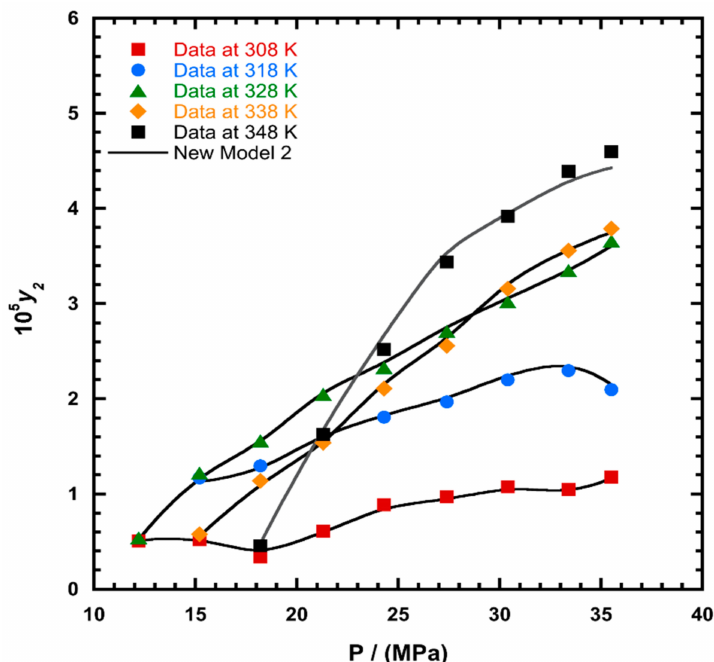
Figure 3. Plot of mole fraction ( y 2 ) as a function of pressure (P/MPa) for 1-amino-2,3-dimethyl-9,10- anthraquinone, the solid line represents the proposed model 2 (Equation